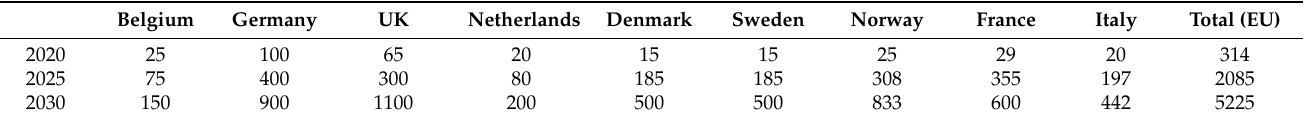
Table 8. Perspectives for the cumulated number of HRS deployed in EU